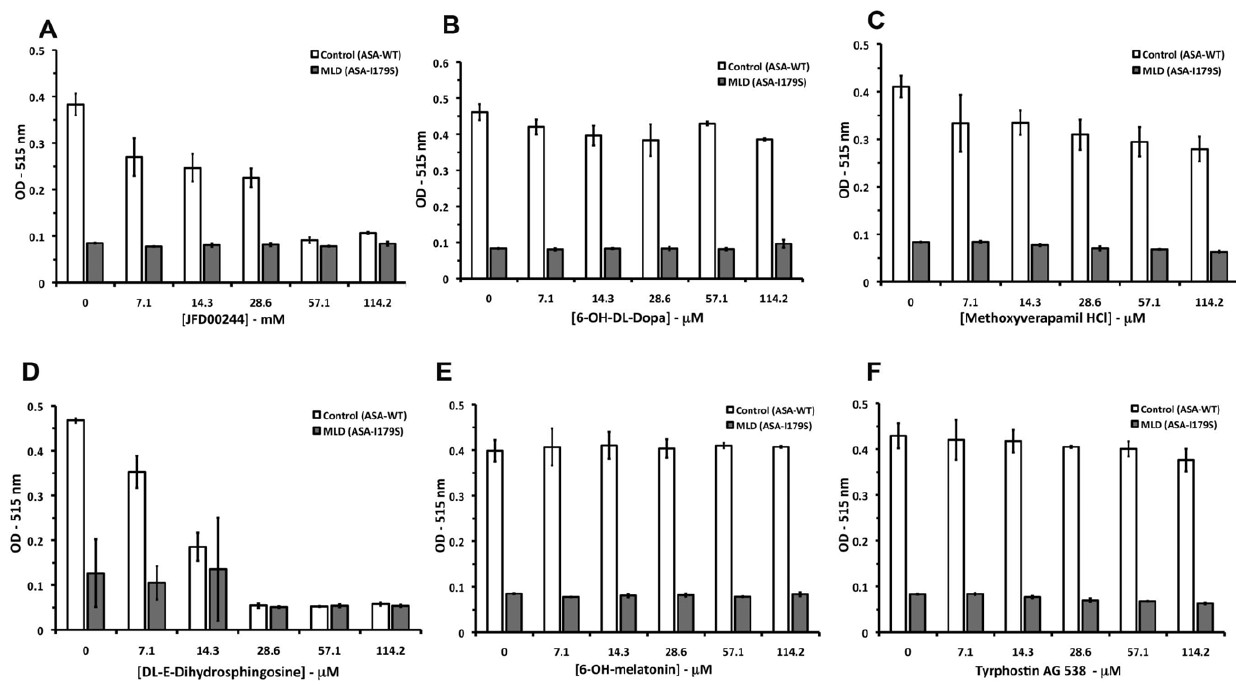
Figure 9. Characterization of candidate compounds in primary culture MLD patient and control cells. The six compounds with concentration-response curves of classes 2.2 and 2.4 were used to treat primary MLD patient (ASA-I179S) and control cells (ASA-WT). The small molecule concentrations used in this assay were within those used in the primary screening. No significant enhancement of residual ASA-I179S enzymatic activity in MLD patient primary fibroblasts was observed. The small molecules tested where those with concentration-response curve of class 2.2: JFD00244 ( A ); 6-OH-DL-Dopa ( B ) and class 2.4: methoxyverapamil HCl ( C ); DL-E-dihydrosphingosine ( D ), 6-OH-melatonin ( E ) and I-Me- Tyrphostin AG 538 ( F ). Reduction of ASA activity in both controls (ASA-WT) and MLD patient fibroblasts (ASA-I179S) were noted as increased concentrations of JFD00244 ( A ), DL-E-dihydrosphingosine ( D ) and methoxyverapamil HCl ( C ).